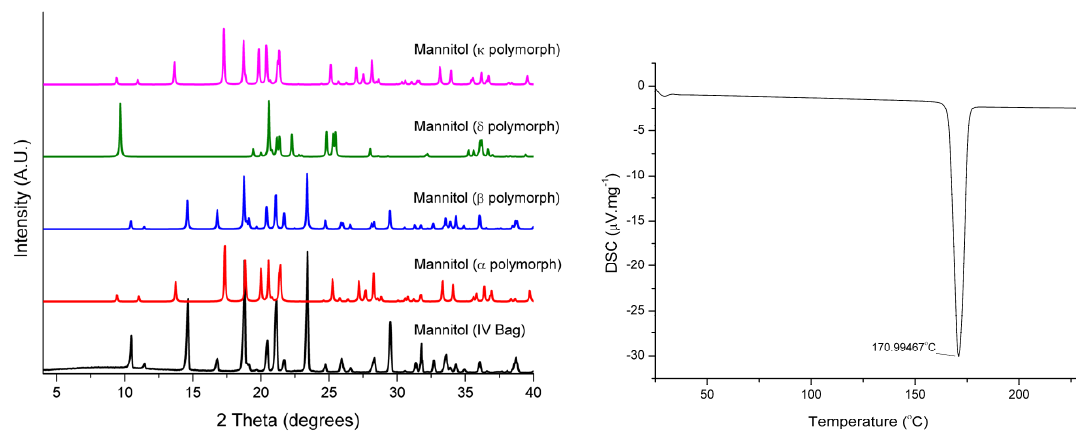
Figure 2. Powder X-Ray Diffraction (PXRD) ( left ) and Differential Scanning Calorimetry (DSC) ( right ) of mannitol crystals removed from the infusion solution.